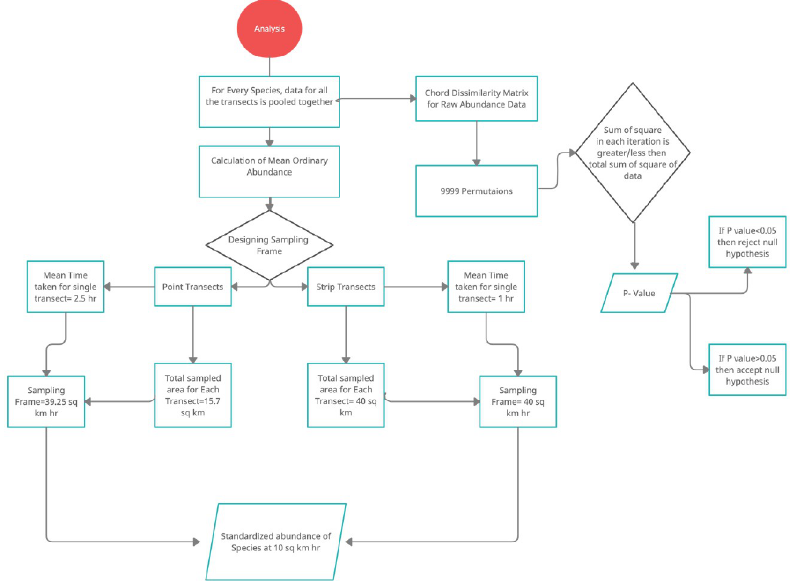
Fig 2. Flow chart for standardized and raw abundance analysis of raptors in winter seasons from roadside point count and strip transect methods in the arid region of Rajasthan.